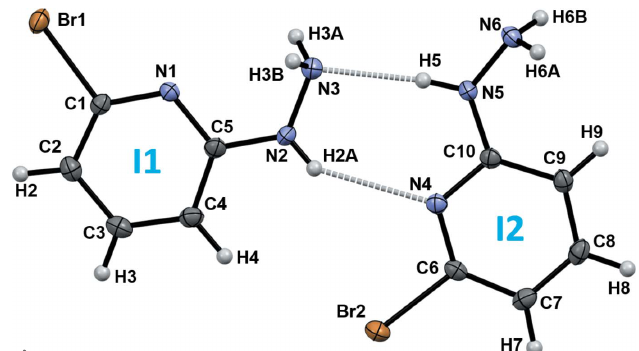
Figure 1 Atomic numbering and displacement ellipsoids at the 50% probability level for molecules ( I1 ) and ( I2 ). Hydrogen bonds are shown as dashed lines.